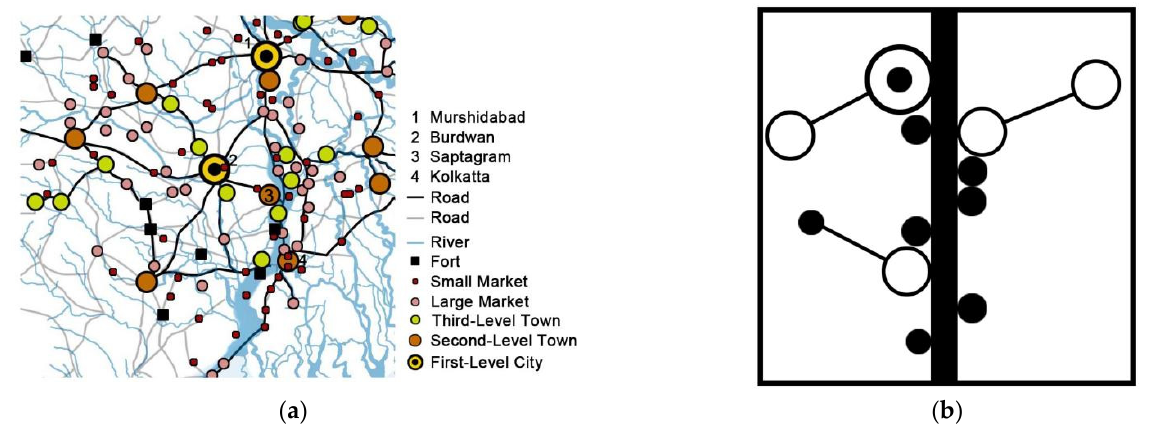
Figure 14. ( a ) Spatial pattern of the city network in the western GBM Delta. Source: the authors; Base Map: Google satellite map; Reference: [65]; ( b ) Belt pattern dominated by industry and commerce. Source: the authors.